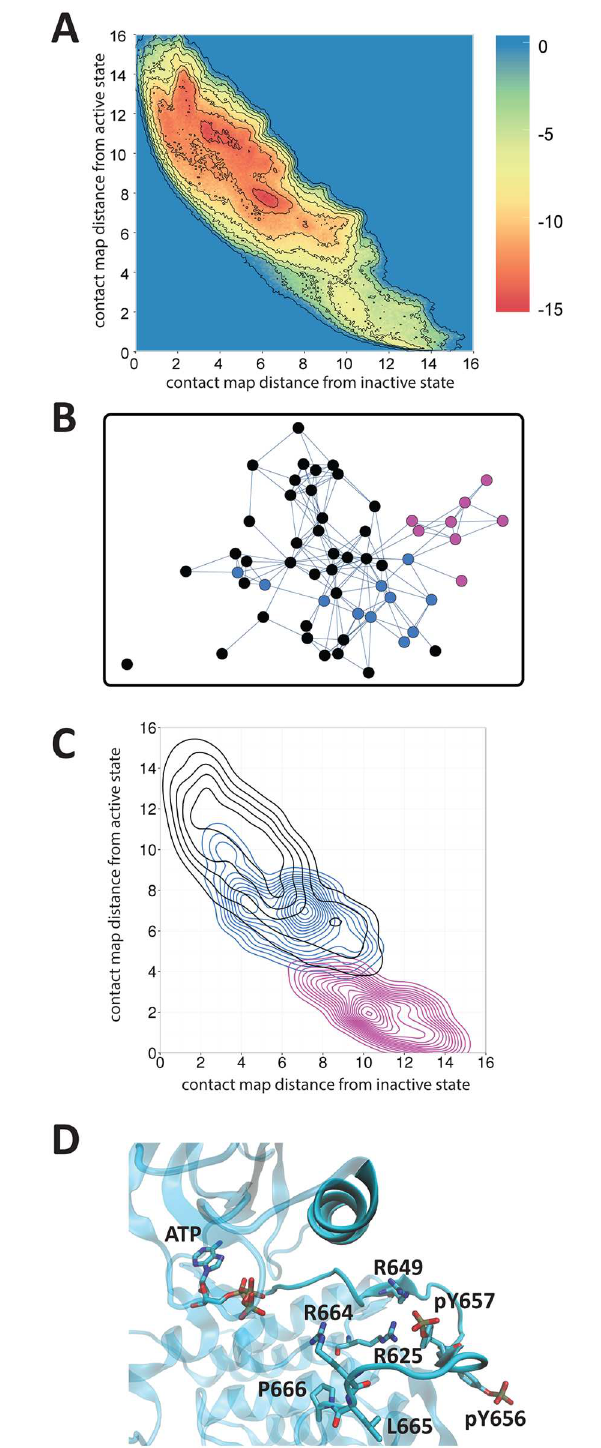
Fig 3. Results of metadynamics simulations. (A) Free energy landscapeof metadynamics simulation. The brown dotted outline corresponds to the outermost blue contour in (C). (B) Network diagram of clusters from metadynamics simulation. Each cluster represents conformations whose backboneis within a 3.0 Å RMSD, and connectedclusters are whose backbonesare within 3.8 Å RMSD. Purple clusters represent those in which pTyr657 faces inward toward Arg649 and Arg625. In all these clusters, Arg664 faces into the active site (more than 50% of the conformations in that cluster feature Arg664:C ζ within 8 Å of ATP:P γ ), while